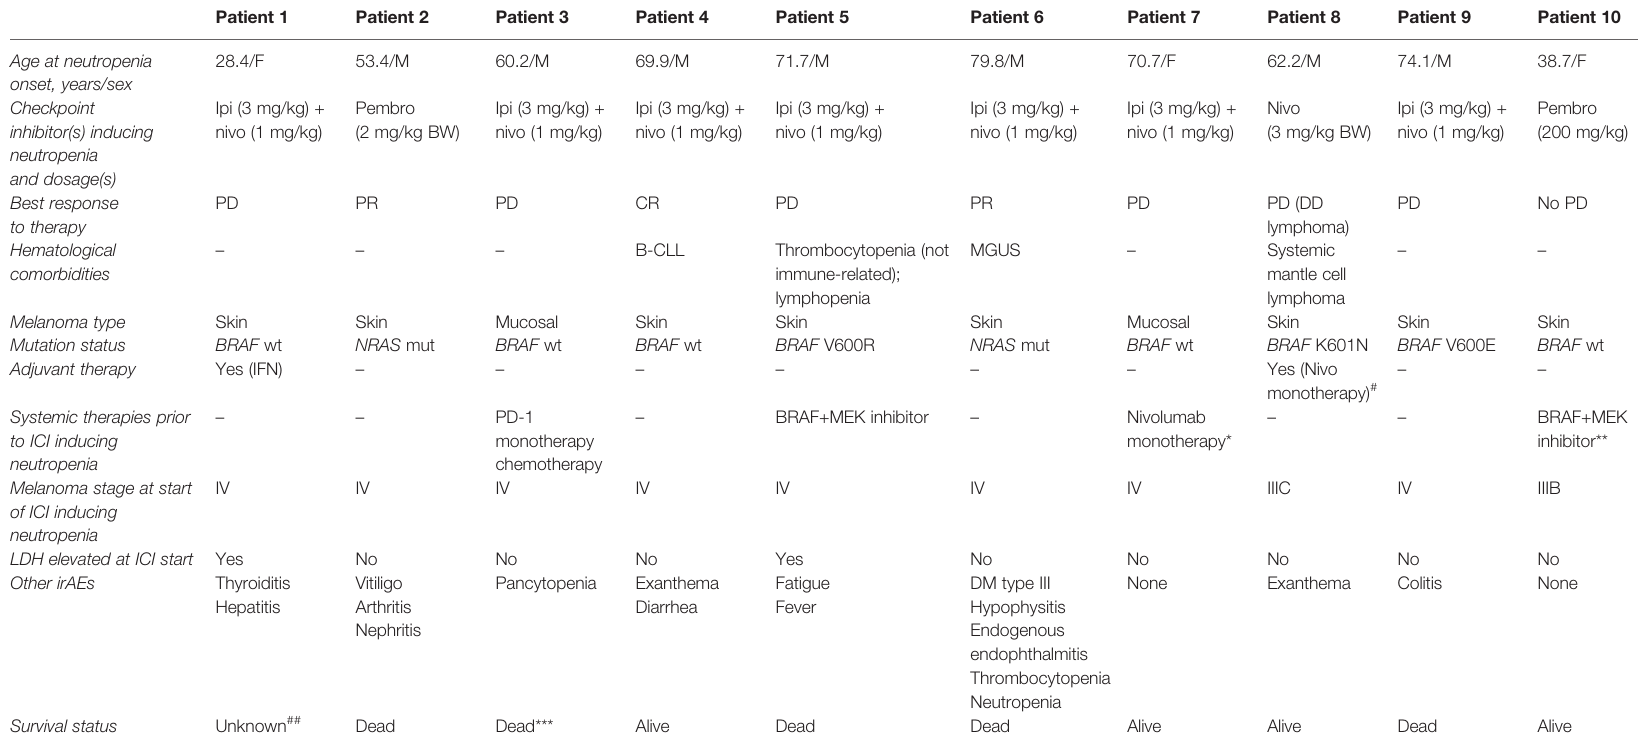
TABLE 1 | Clinical characteristics of patients with